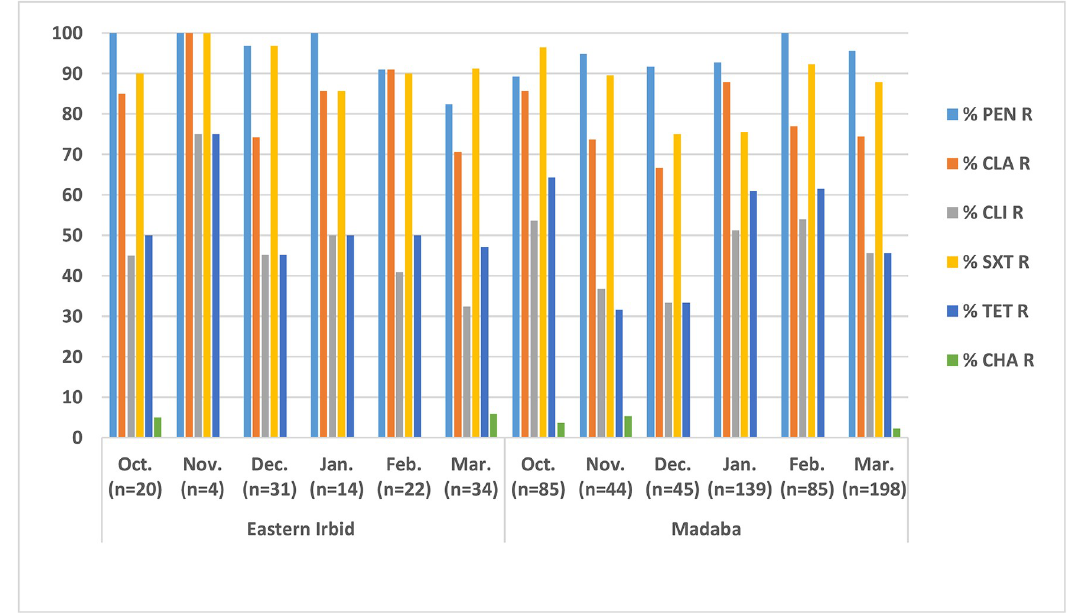
Fig 2. Resistance rates of pneumococcal isolates on monthly basis from eastern Irbid and Madaba in both winter seasons. Abbreviations: PEN (Penicillin), CLA (Clarithromycin), CLI (Clindamycin), SXT (Sulfamethoxazole-Trimethoprim), TET (Tetracycline), CHA (Chloramphenicol).